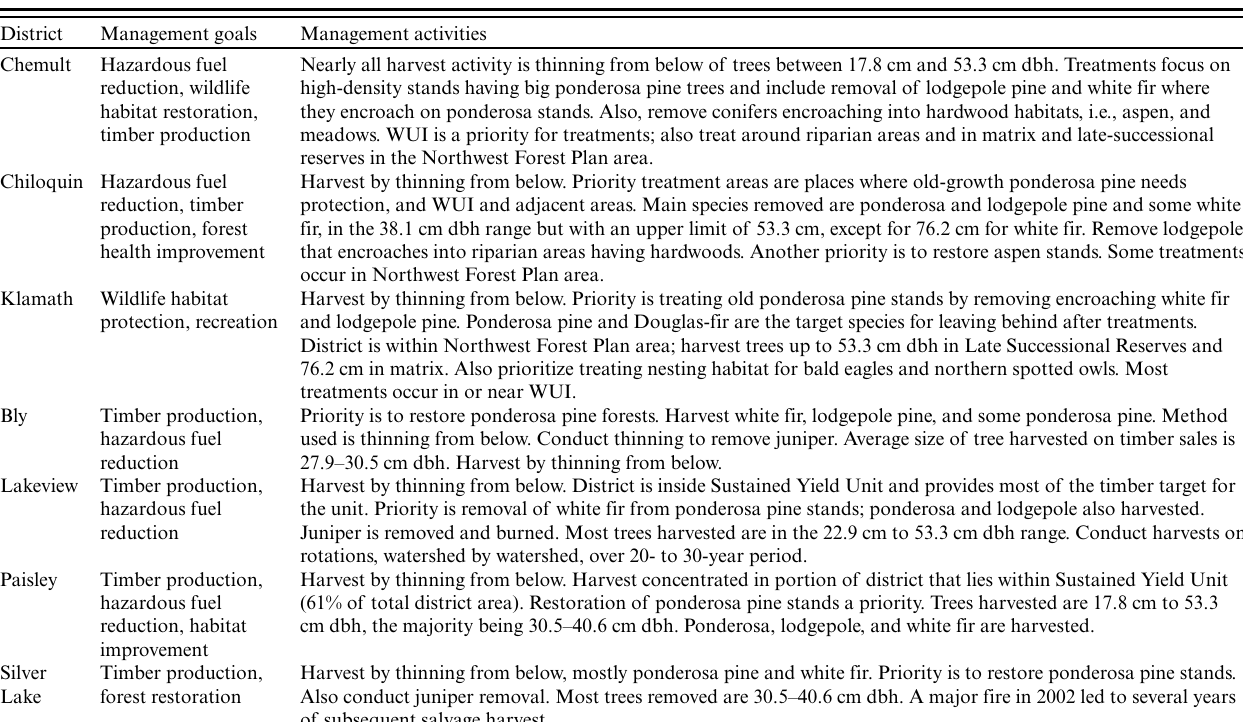
Table 3. Forest management, Fremont-Winema National Forest Districts District